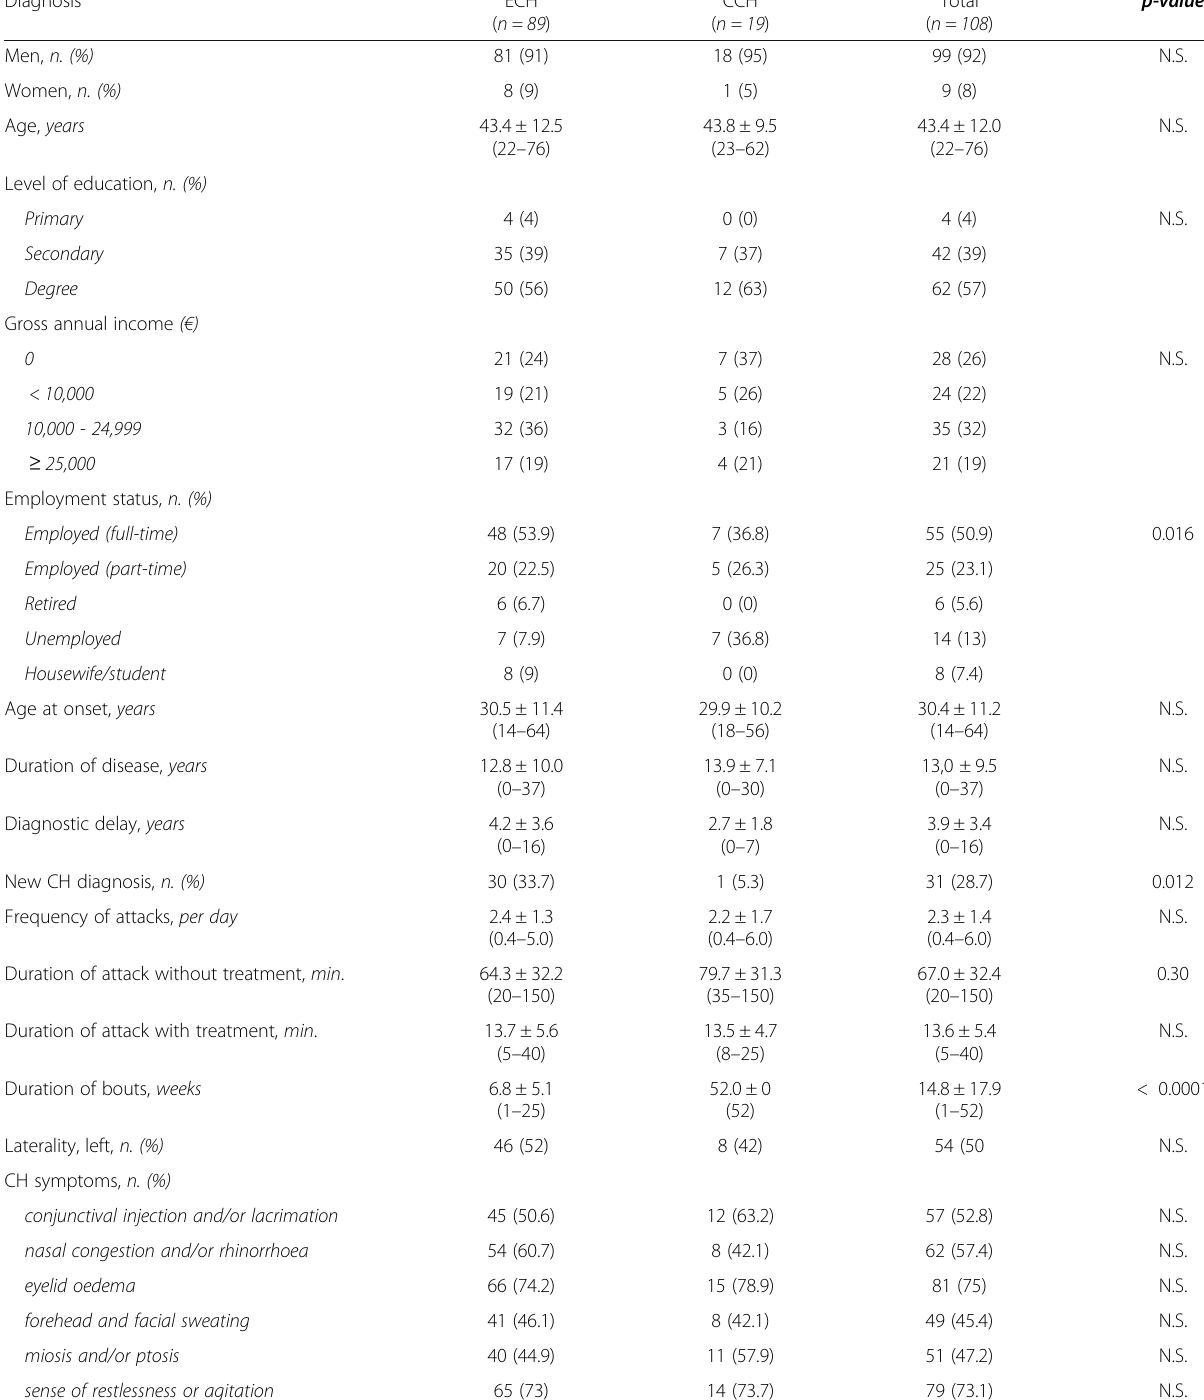
Table 1 Patients characteristics: demographic, occupational and